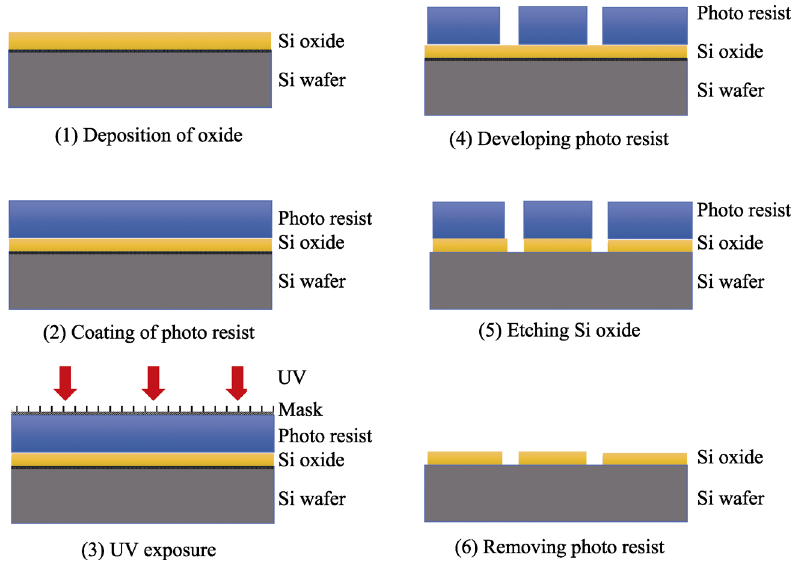
Fig. 25 A schematic diagram of etching micromachining.